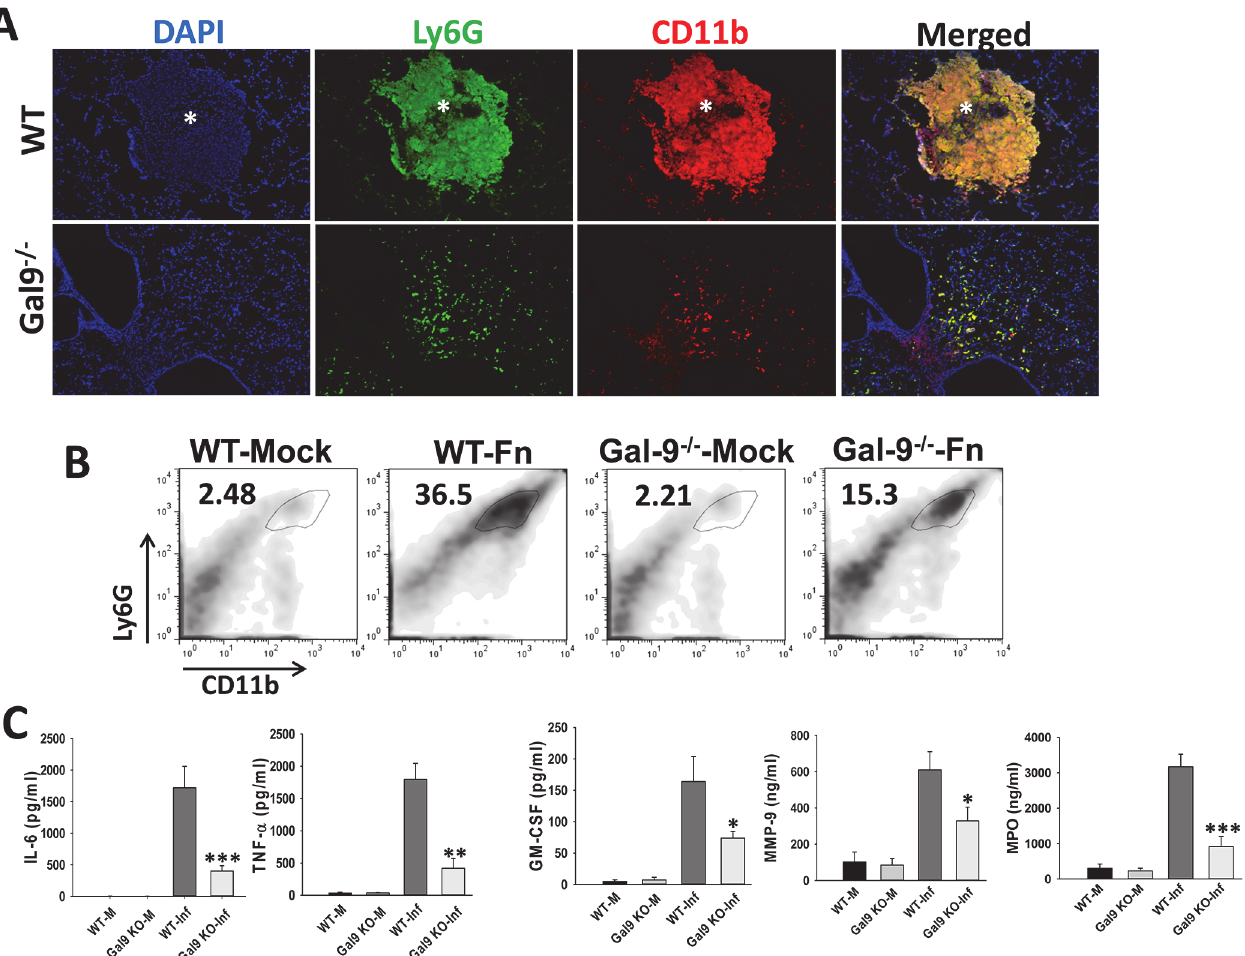
Fig 3. Gal-9 -/- mice display reduced accumulation of neutrophils and reduced inflammatory mediators in lungs during F.n. infection. (A) Frozen sections of lungs harvested at 3 dpi from F.n. infected WT or Gal-9 -/- mice were co-stained with antibodies against myeloid cell markers CD11b (red) and Ly6G (green). A high co-expression of both markers is depicted by yellow color and indicates neutrophils. Nuclei (blue) were stained with 4 ’ 6 ’ diamidino- 2-phenylindol-dilactate (DAPI). Magnification X 200. Asterisks depict lesions in the lungs. (B) Flow cytometry analysis of neutrophils in mock control and F.n. infected WT and Gal-9 -/- (WT-Fn and Gal-9 -/- -Fn) mice. Total lungs cells were isolated from mice by collagenase treatment at 3 dpi as described in Methods. The cells were stained with anti-Ly6G-APC and anti-CD11b-Pacific Blue antibodies as markers for neutrophils. The plots are representative of three mice per group in 3 independent experiments. (C) Lungs from mock infected and F.n. infected WT or Gal-9 -/- mice were harvested at 3dpi, homogenized with protease inhibitors in PBS and analyzed commercially for rodent multi-analyte profiles (Myriad Rules-Based Medicine, Austin, TX). Levels of inflammatory cytokines and neutrophil markers in lung homogenates are shown. Results shown are from 3 – 4 mice per group from 3 different experiments. MMP-9; matrix metalloproteinase 9, MPO; myeloperoxidase. * p < 0.05; ** p < 0.005; *** p < 0.001. Comparisons were made between infected WT and Gal-9 -/-